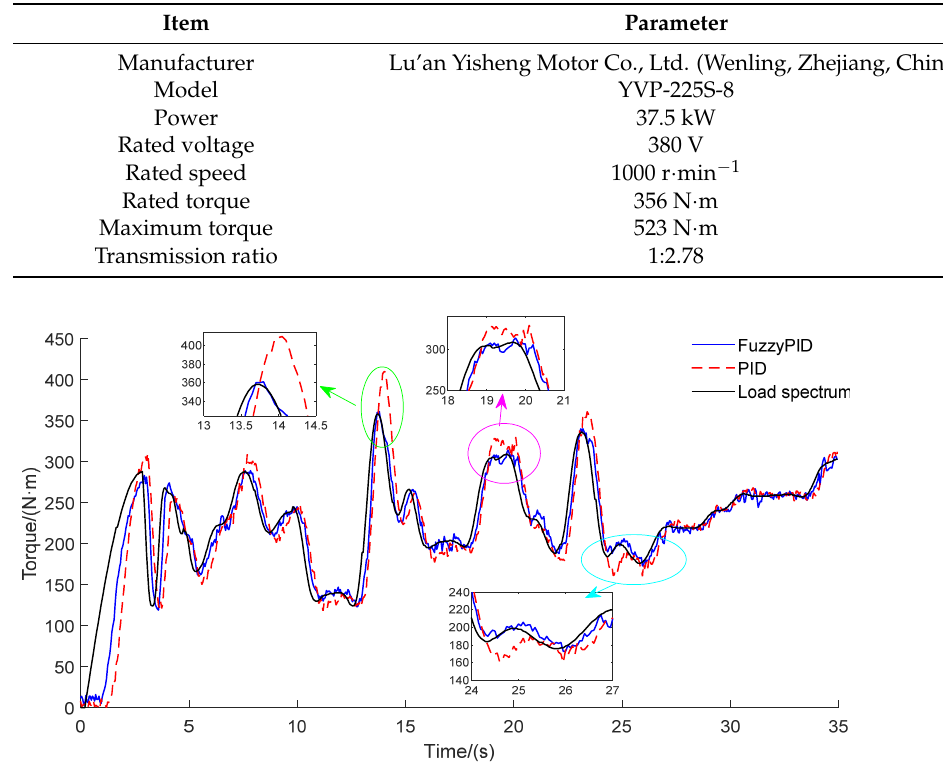
Figure 12. Test results of the first 35s loading data.